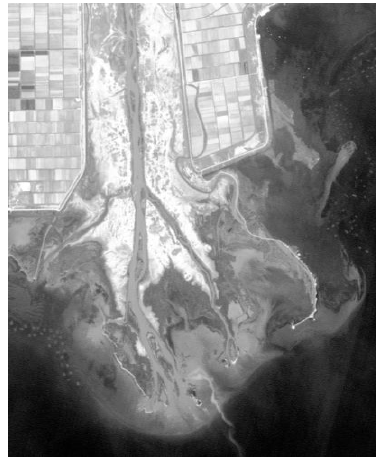
Figure 4a. Axios delta – histogram equalization